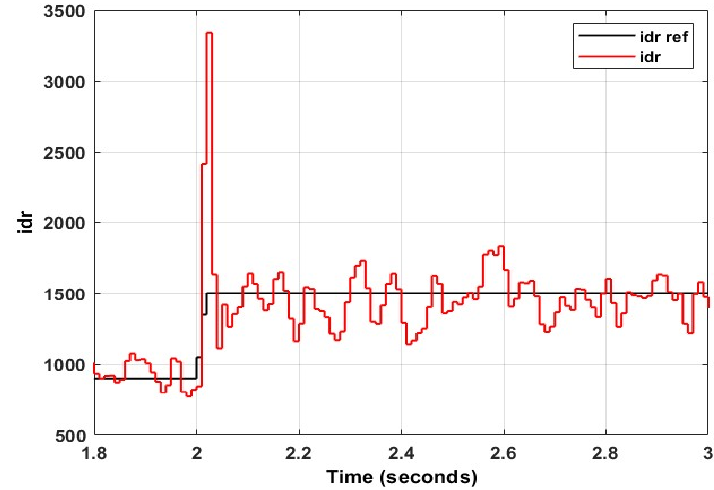
Figure 47. Rotor direct axis current ripple using PI at 90% dip.